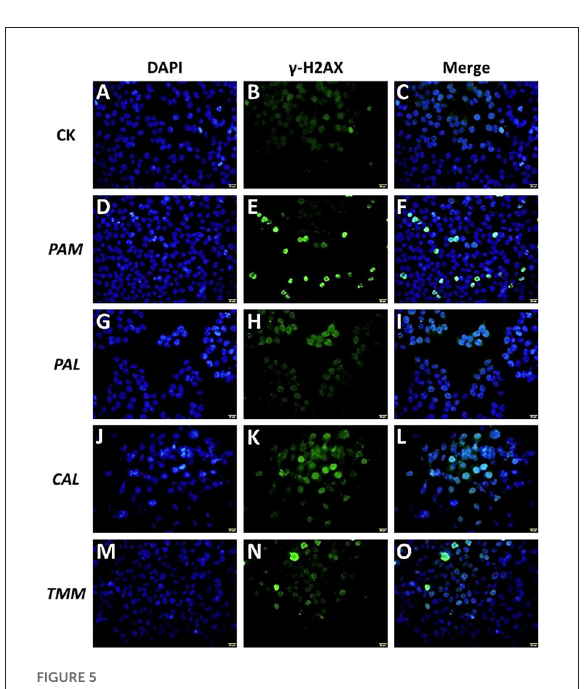
FIGURE5 Effects of extracts ( PAM : D–F , PAL : G–I , CAL : J–L , and TMM : M–O ) on γ -H2AX protein in HGEC after being exposed for 24h. Background control (CK) was artificial saliva alone (A–C) . The immunofluorescent photographs of the phosphorylation of histone H2AX in γ -H2AX-stained HGEC (Green: B,E,H,K,N ) and the counterstained nuclei with DAPI (Blue: A,D,G,J,M ) were captured. Blue dots were cell nuclei, green dots indicated DNA damage. The magnification was 60 × and the scale bar ( A–O : yellow, located in the lower right corner) is 20 µ